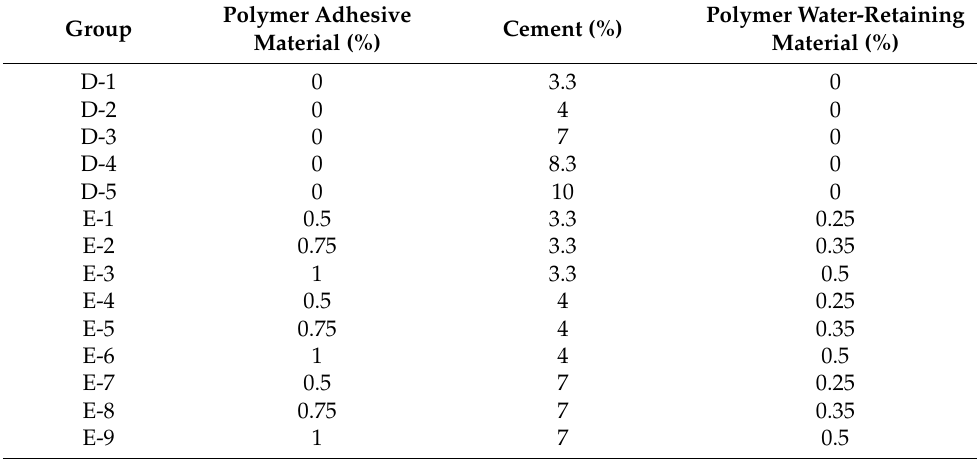
Table 3. Addition of material to